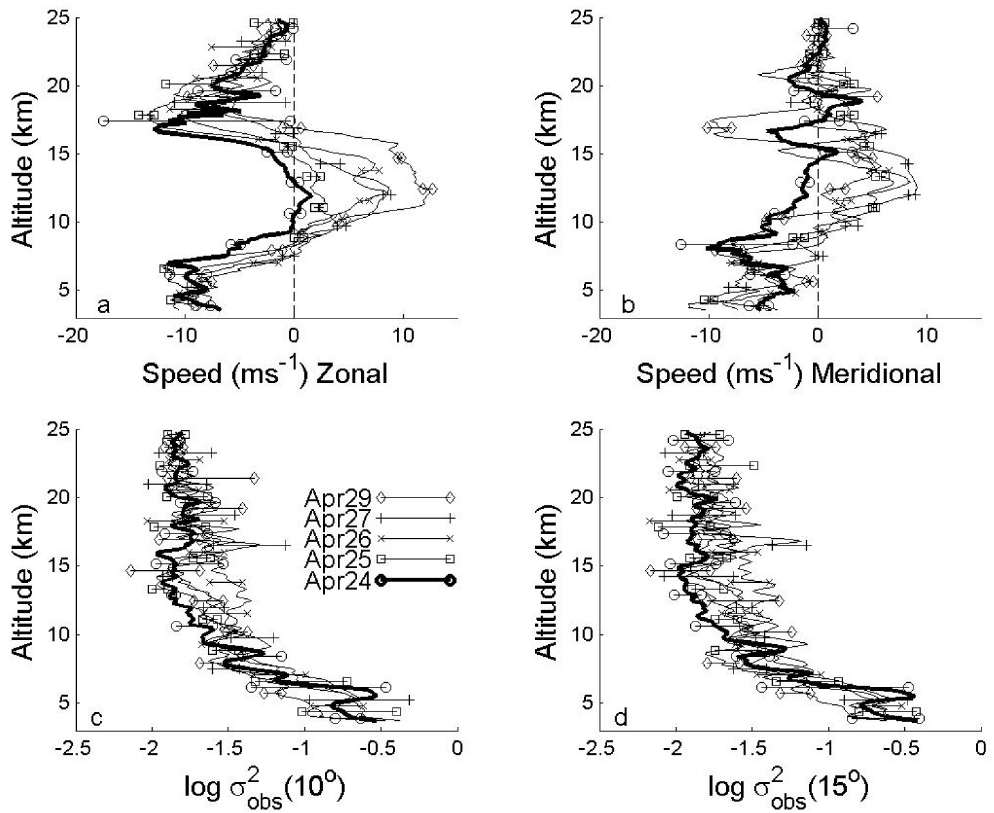
Fig. 1. (Upper) Zonal and meridional wind speeds for each day, April 2002. The plotted curves are the means of the daily medians for the two opposing beams in each plane and for 10 ◦ and 15 ◦ zenith angle; the symbols show the maximum and minimum values used for each mean. (Lower) Daily means of the observed spectral widths at 10 ◦ and 15 ◦ zenith